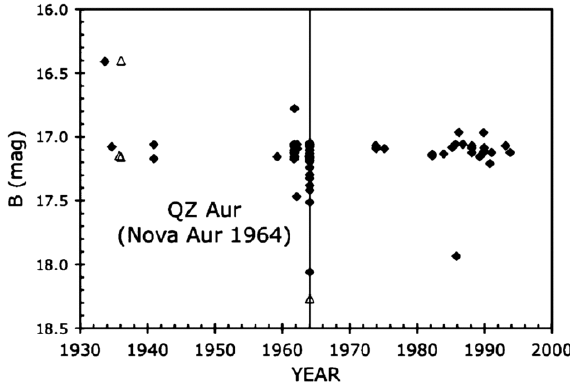
Figure 1: QZ Aurigae, Nova Aurigae 1964, is a text- book example of the findings of Collazzi et al. (2009), who showed that for nearly all novae, the pre- and post- eruption magnitudes are identical, and that on average ∆ m = m pre − m post across all nova eruptions is consis- tent with 0. Figure reproduced with permission from Collazzi et al. (2009).